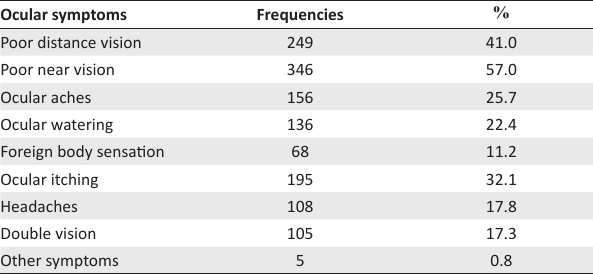
TABLE 2: Ocular symptoms of the 607 participants (multiple responses were given by some participants).